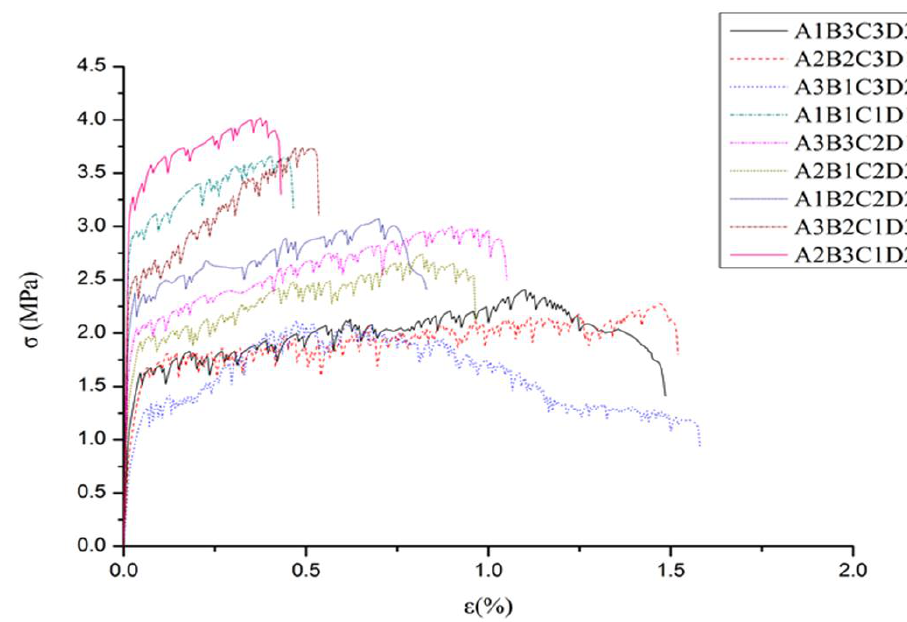
Figure 5: Tensile Stress - strain Curve of 9 experimental